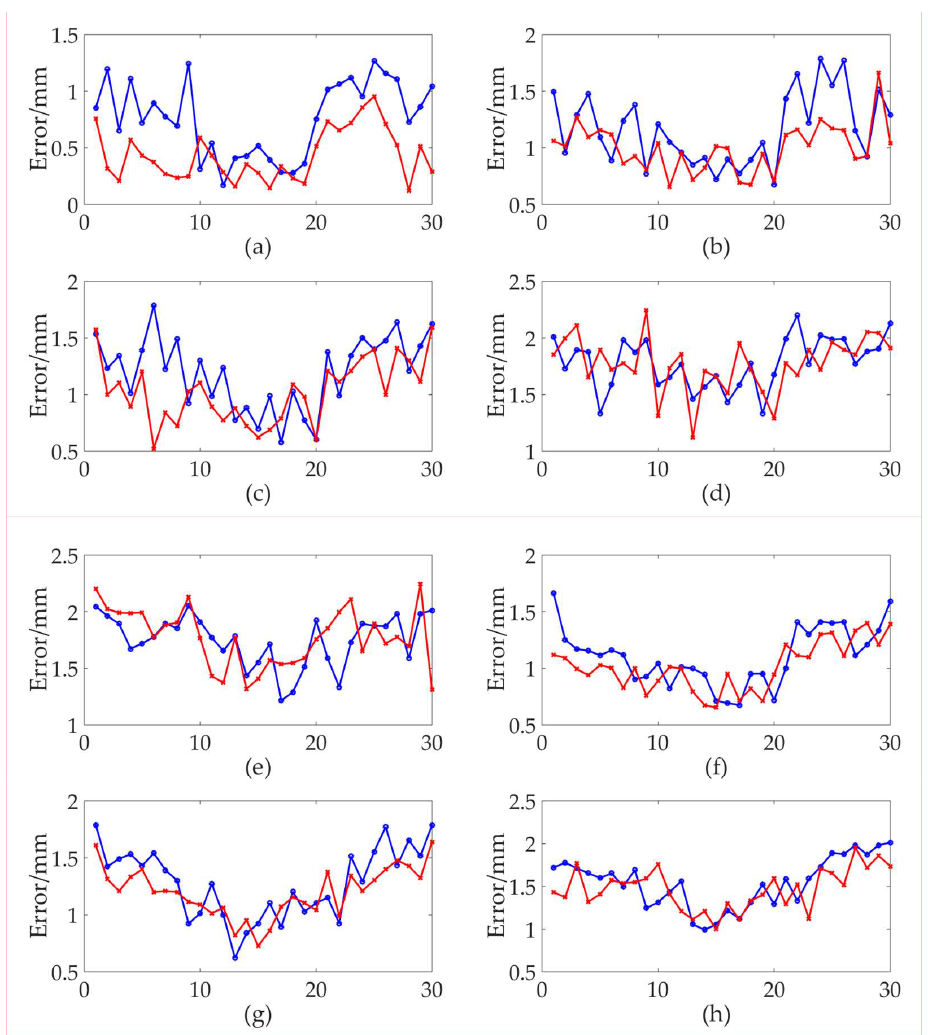
Figure 7. The measurement errors of the two calibration methods (the blue line represents the conventional method and the red line represents the novel method). ( a ) The experimental results of A area; ( b ) The experimental results of B area; ( c ) The experimental results of C area; ( d ) TheexperimentalresultsofDarea;( e )Theexperimental resultsofEarea; ( f )TheexperimentalresultsofFarea; ( g )TheexperimentalresultsofGarea; ( h